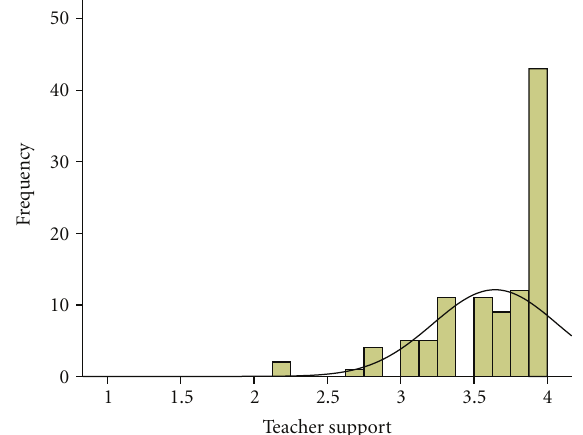
Figure 2: Histogram displaying frequencies of the amount of youth-perceived teacher support